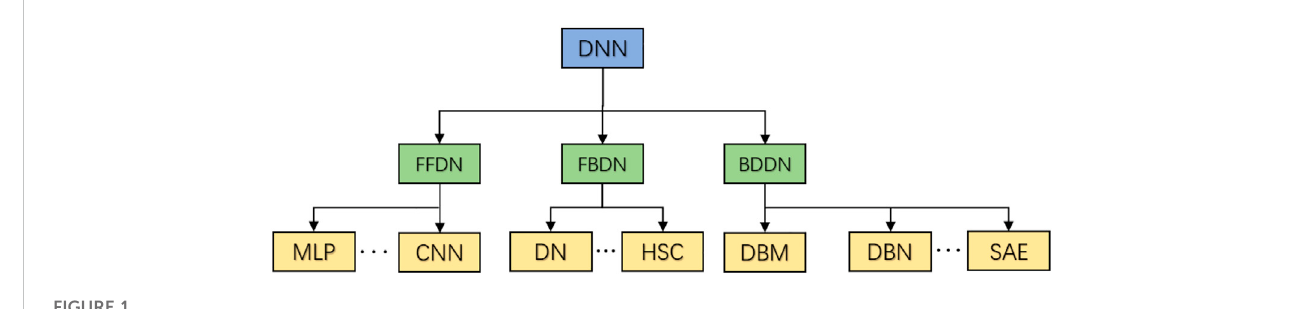
FIGURE 1 Deep neural network classi fi cation